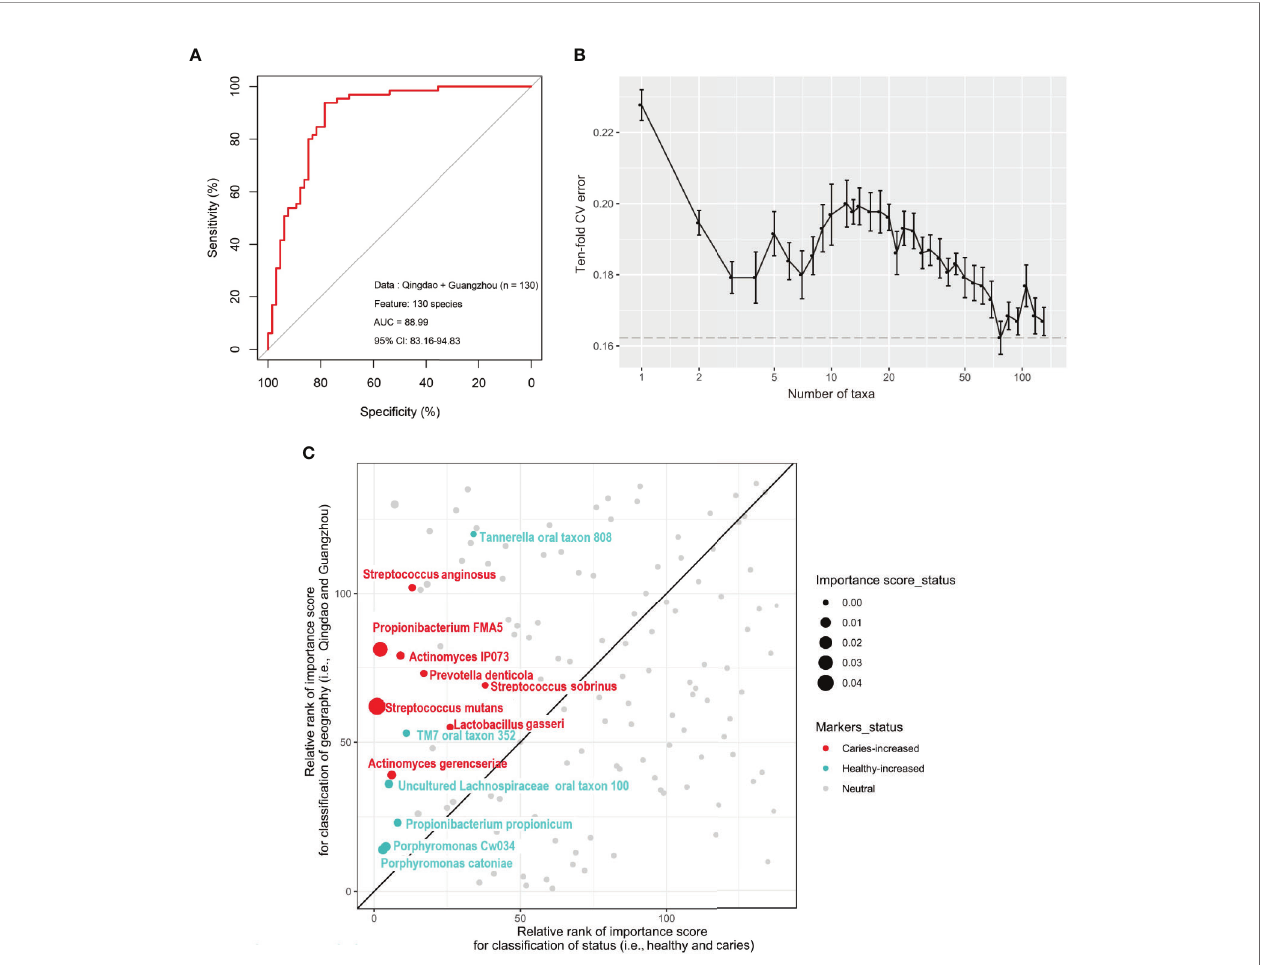
FIGURE 5 | Caries diagnostic models based on oral microbiome detrended for geography. We constructed caries diagnostic models using 130 oral microbial species from both Qingdao and Guangzhou populations. (A) Saliva microbiota can predict caries status with a remarkably high accuracy (AUC=88.99%). (B) The relationship between the numbers of variables used in the reduced Random Forest model and the corresponding predictive performance (the error bar denotes SD). (C) The most caries-discriminatory taxa (N=14) do not correlate with geography. The scatterplot shows the relative rank of microbial markers in both Random Forest models for classifying disease status and geographic locations. Any dots on the reference line which slope=1 suggests a taxon is equally important to both disease states and